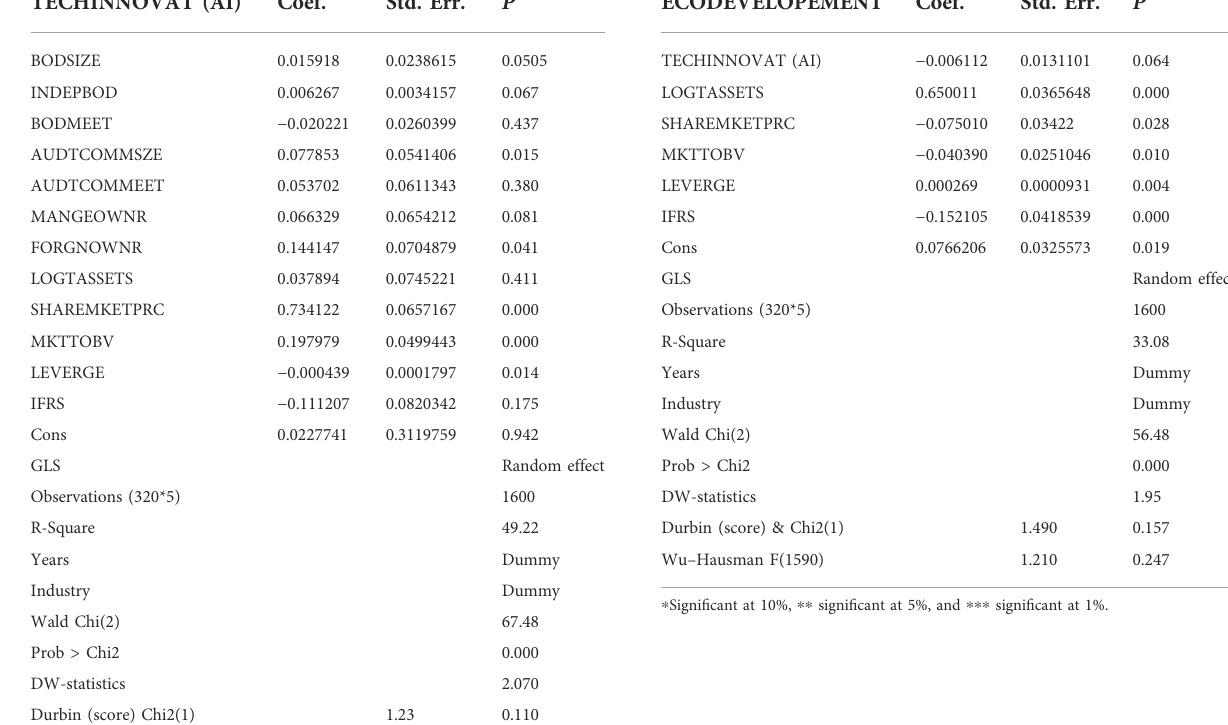
TABLE 5 Random effect (GLS) model 3 (A to